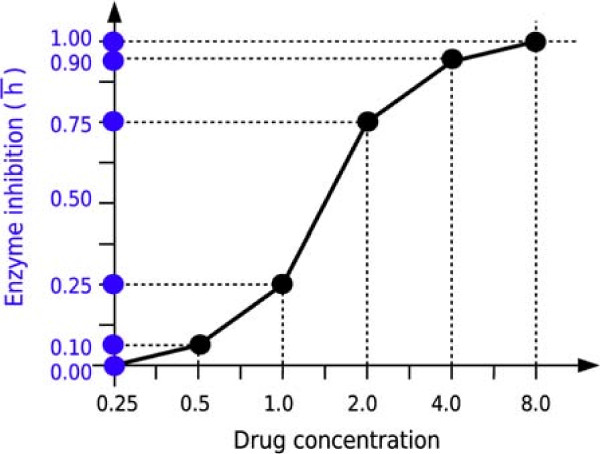
Constructing the inhibition h from the experimental dose-response curve: an example. The points of the curve are hypothetical experimental measurements of the effect of the drug on the activity of the enzyme. The discretization of the curve can be used as basis for the discretization of the interval [0,1]: therefore, referring to (10), we may define hk = 0.10xk,0 + 0.15xk,1 + 0.50xk,2 + 0.15xk,3 + 0.10xk,4.